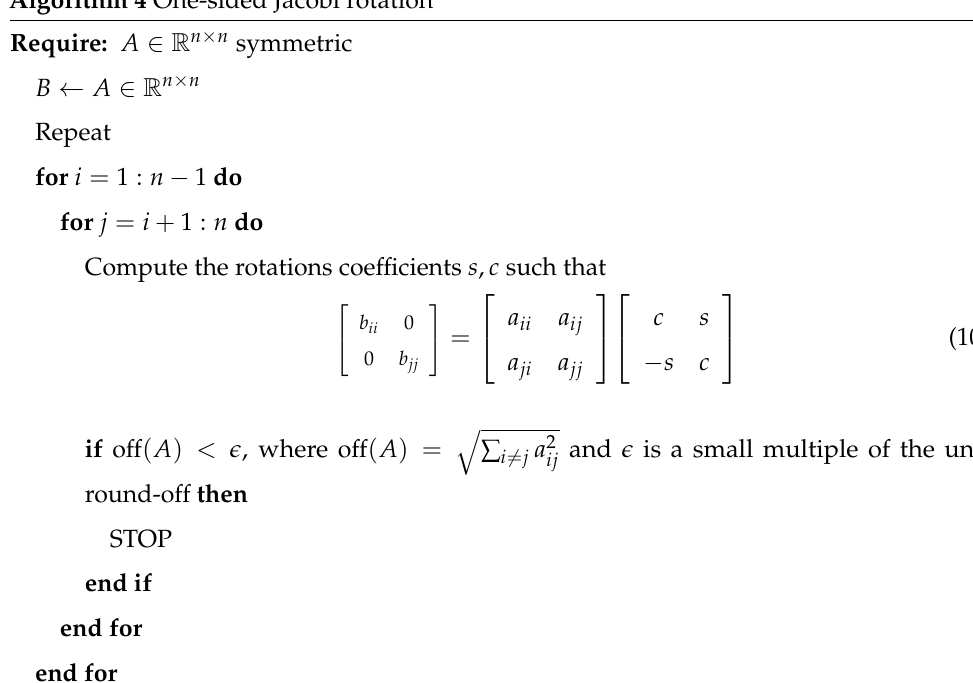
Algorithm 4 One-sided Jacobi